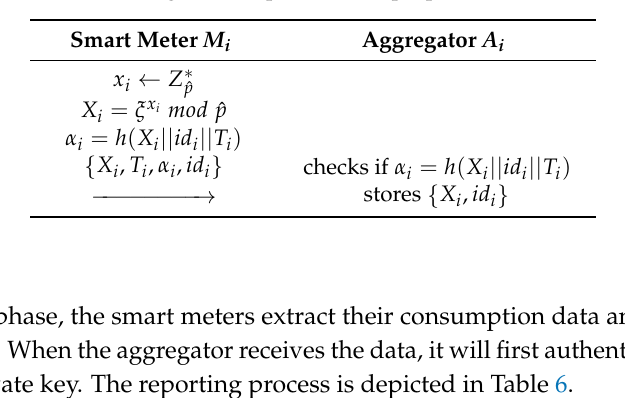
Table 5. Registration phase of the proposed